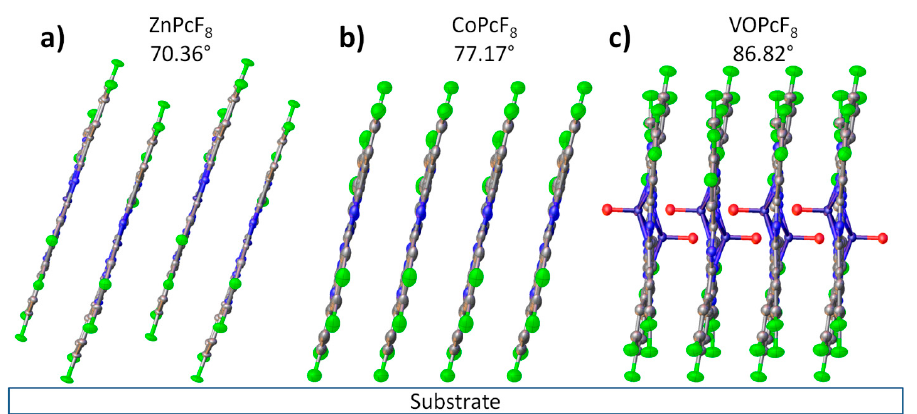
Figure 8. Orientation of ZnPcF 8 ( a ), CoPcF 8 ( b ), and VOPcF 8 ( c ) molecules in the thin films relative to the substrate surface.